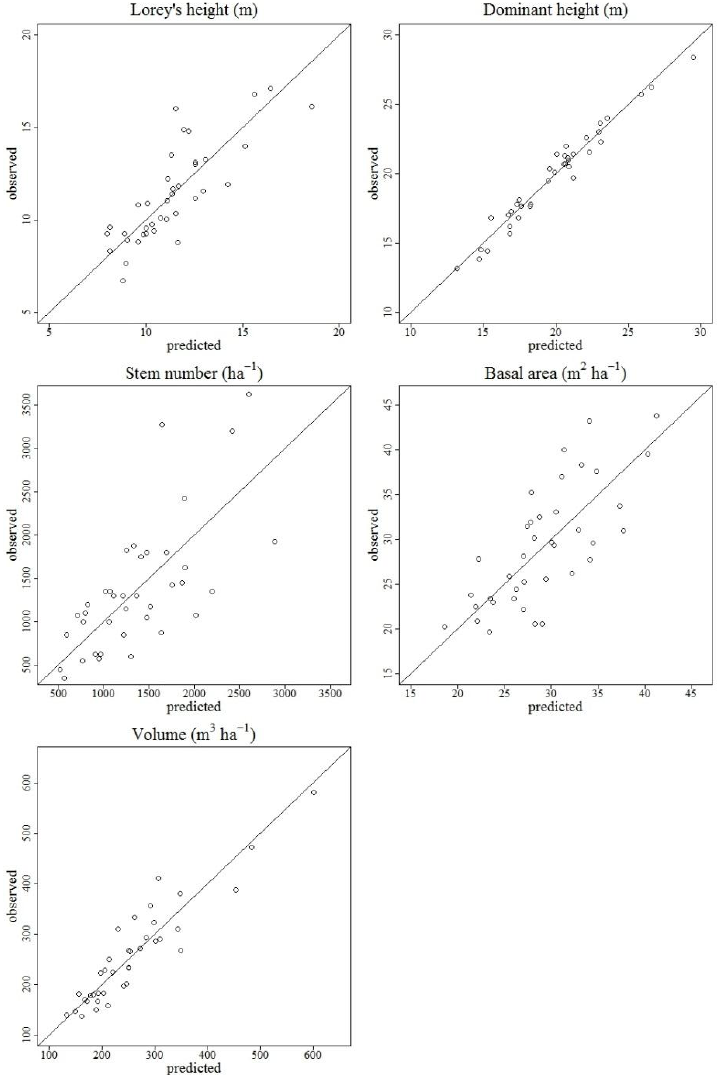
Figure 4. Scatterplot of observed versus predicted values from the cross validation for the models, including height, density, and spectral